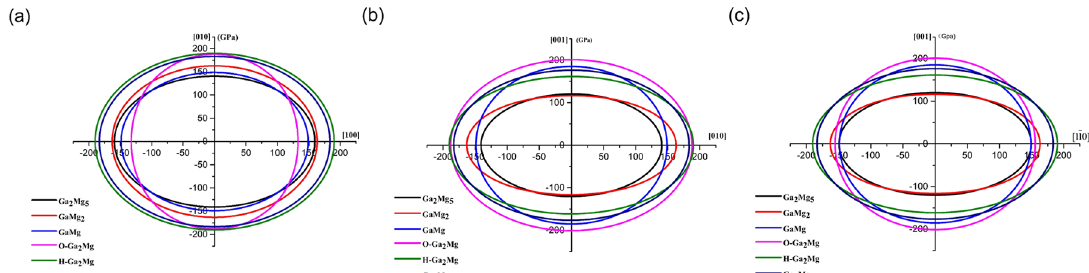
Table 4. The calculated universal anisotropic index (A U ), percent anisotropy (A of Ga-Mg system.